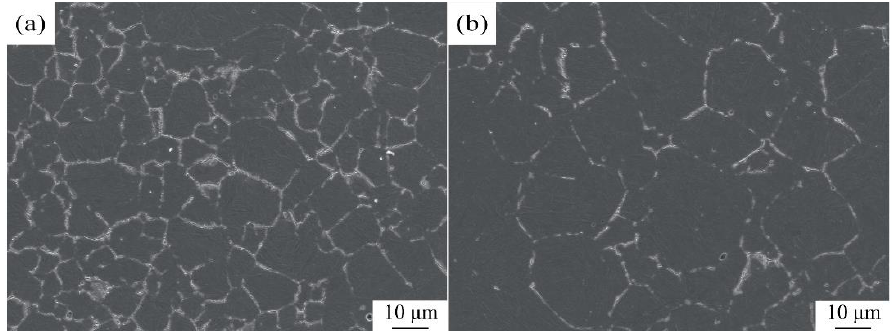
Figure 4. Distribution of PAG boundaries for the steels quenched at 850 °C, ( a ) oxide addition, ( b ) conventional.